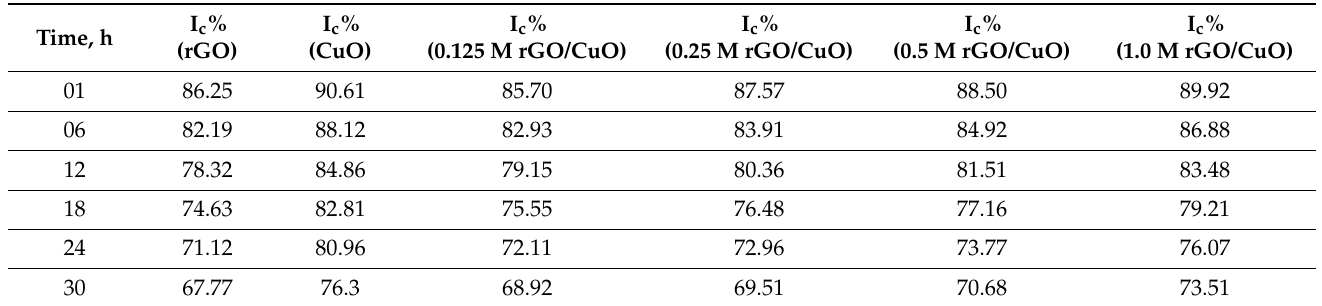
Table 2. Effect of rGO molarity concentration on crystallinity index (I c ) of rGO, CuO, and rGO/CuO at different test periods and 500 °C.